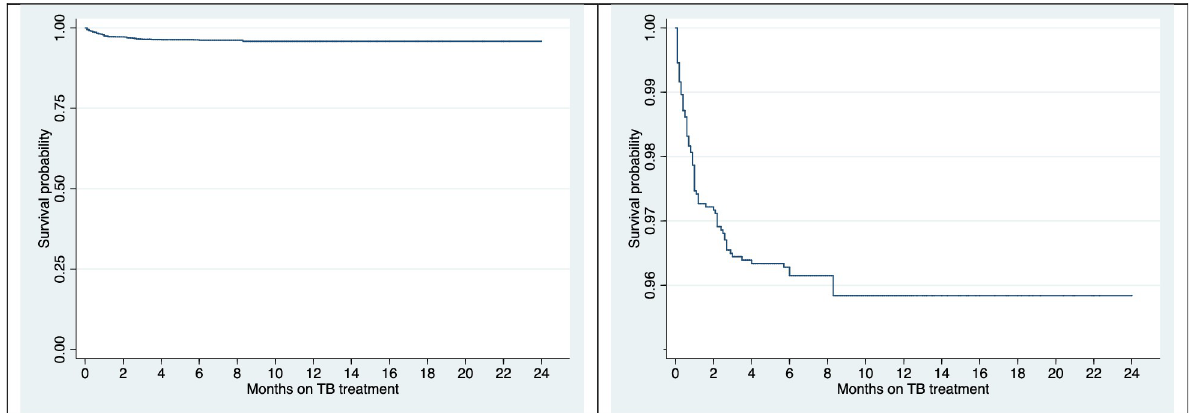
Fig 1. A and B 1 Survival curve of patients with TB related death 2 in Denmark 2009–2014. 1: Magnified view of the survival curve 2: The sum of TB related death (death from another cause had been precipitated by TB disease) and death caused by TB (TB disease lead directly to organ failure or fatal